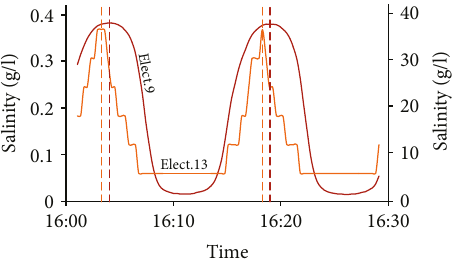
Figure 7: Vertical time lag within the FSI where the lower electrode 9 lags behind the upper electrode 13. Vertical dashed lines denote the peak timings. fl uctuations (Figure 6). The salinity at the FSI (electrode #28) lags behind both water content sensors. All these sensors are aligned vertically 18cm from the left boundary. This vertical time lag trend exists also within the FSI where the lower elec- trode #9 also lags behind the upper electrode #13 (Figure 7).